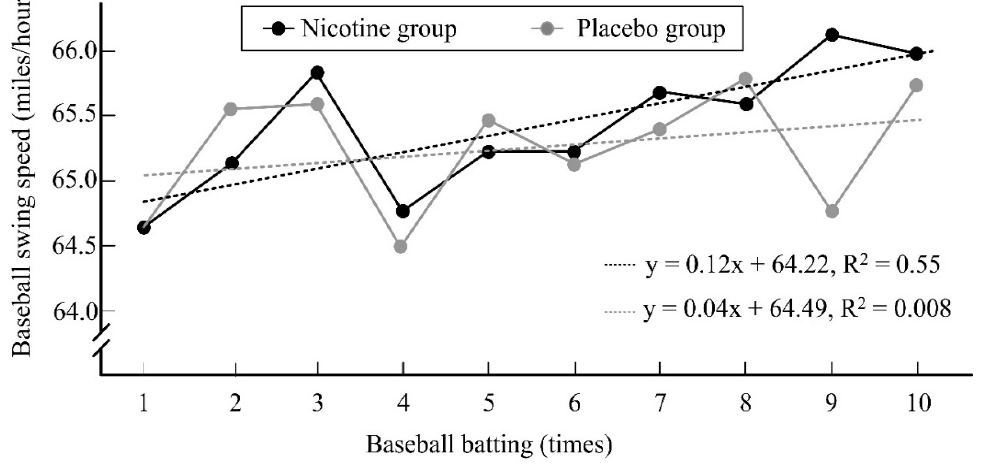
Figure 3. The changes over baseball batting time on the slope of baseball swing speed in both groups.